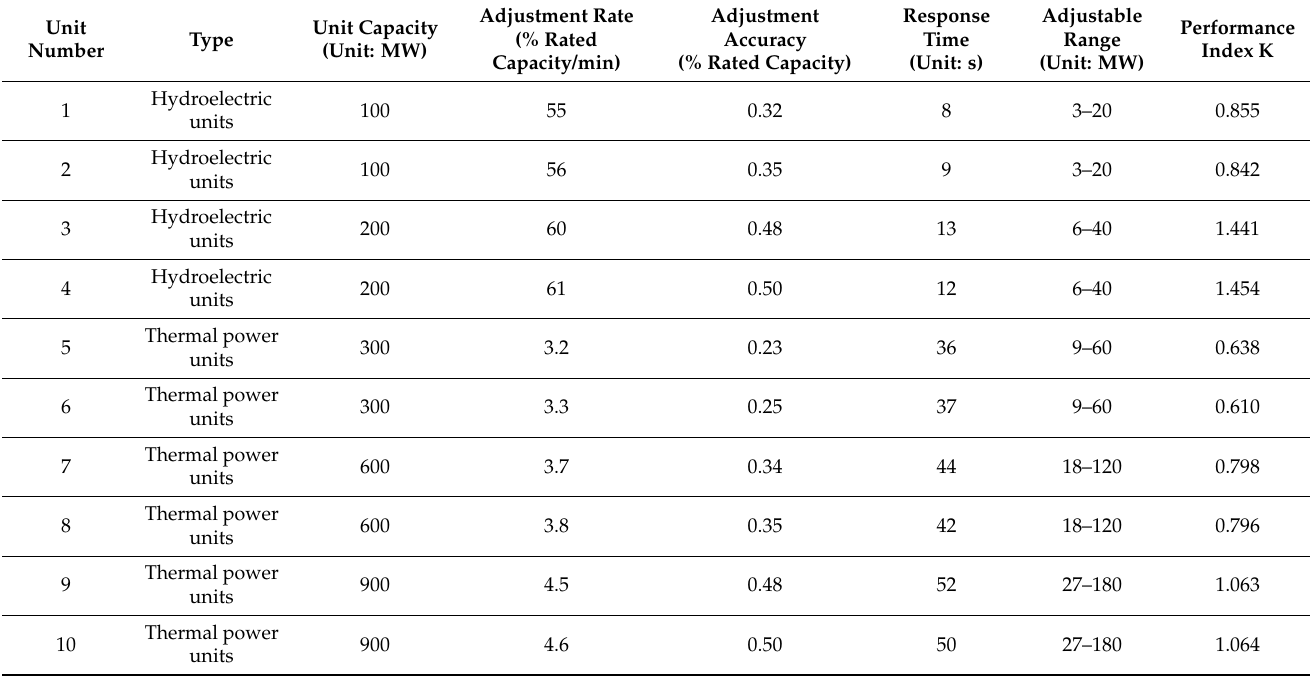
Table 3. Technical data of frequency regulation